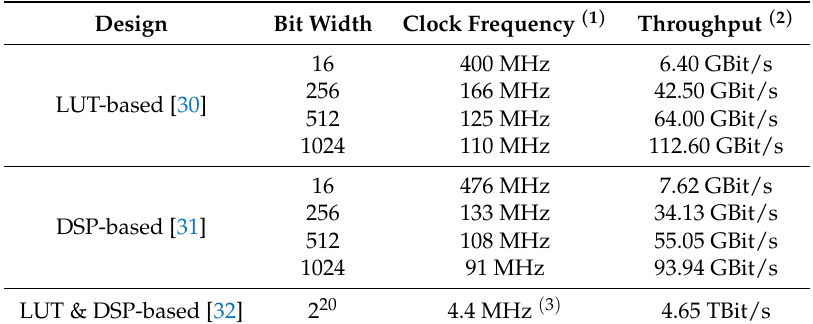
Table 1. Comparison of three FPGA implementations to determine population counts. All designs leverage only one computation unit.